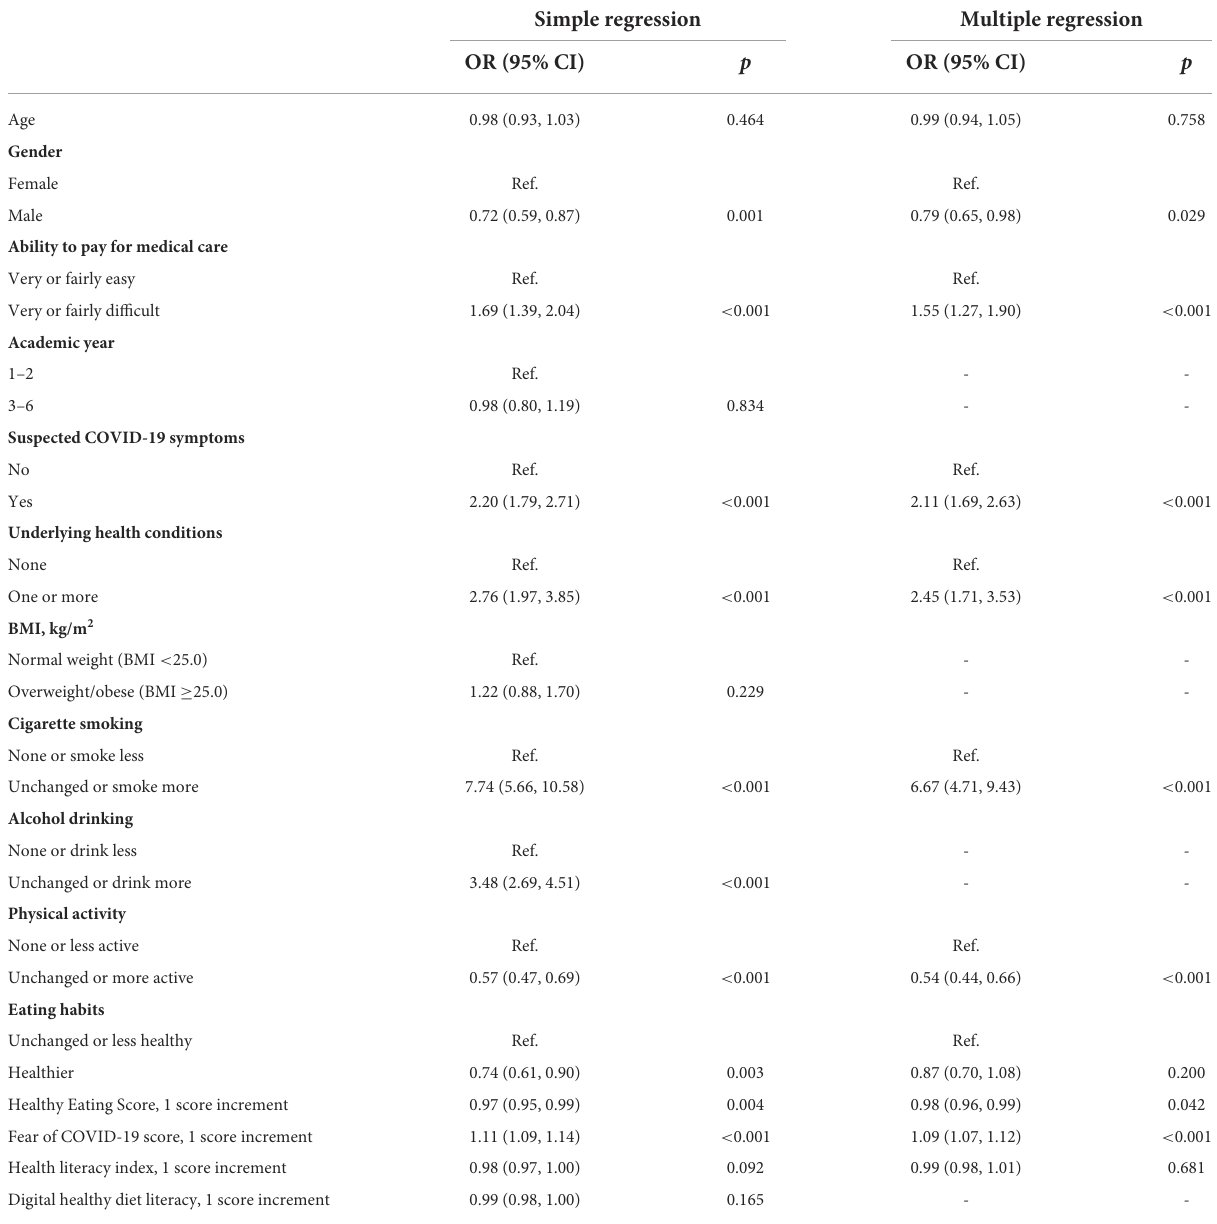
TABLE 2 Factors associated with anxiety disorders among medical students ( n = 5765). Variables Anxiety disorders Simple regression Multiple